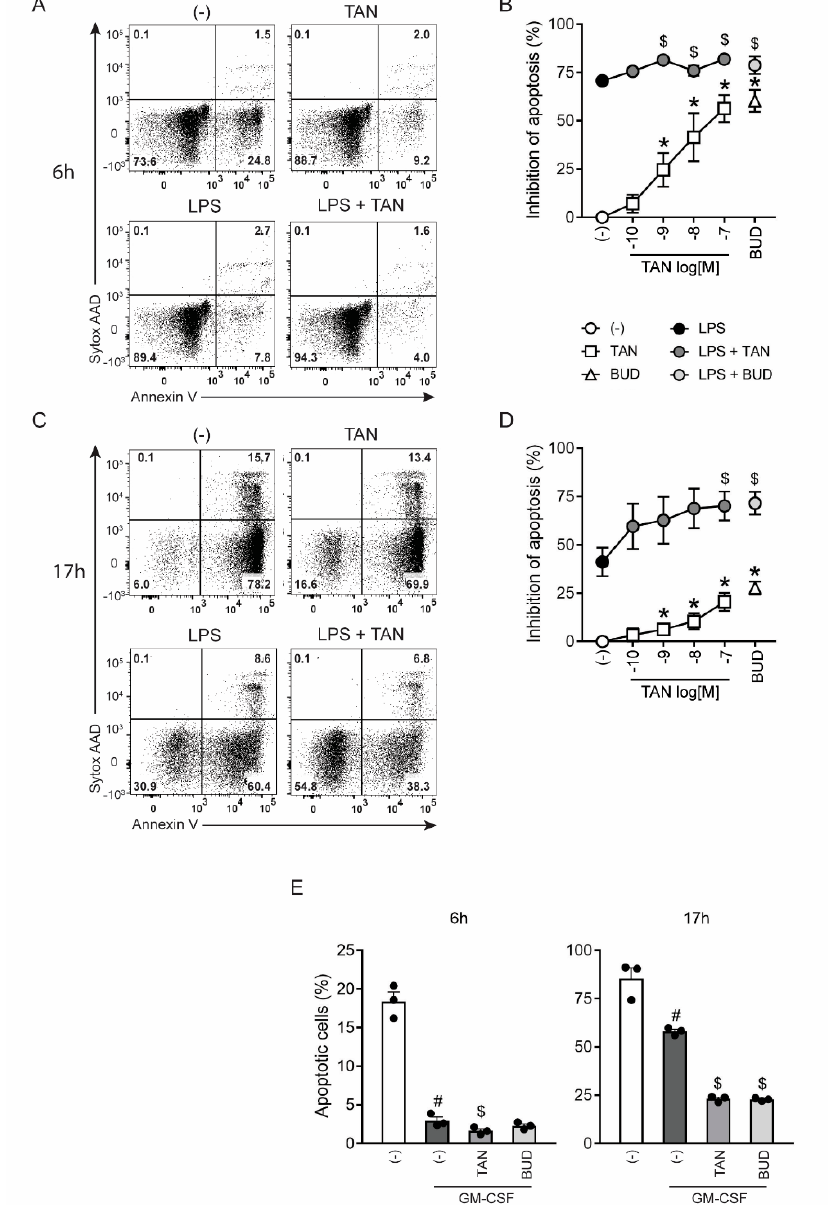
Figure 6. Tanimilast protects neutrophils from apoptosis. ( A – D ) Isolated neutrophils were exposed to the indicated concentrations of tanimilast and budesonide (10 − 7 M) in the absence or presence of LPS (500 ng/mL) ( A – D ). ( E ) Neutrophils were exposed to tanimilast or budesonide (both at 10 − 7 M) in the presence or absence of GM-CSF (20 ng/mL). Neutrophil apoptosis was assessed by cytofluorimetric analysis of Annexin V positivity in 7-AAD negative cells at 6 ( A , B , E left panel) and 17 h ( C , D , E right panel). ( A , C ) Dot plot from the analysis of one representative donor out of the four. ( B , D ) inhibition of apoptosis (%) by tanimilast (TAN) and budesonide (BUD), in unstimulated (open symbols) and LPS-stimulated neutrophils (closed symbols). Results are expressed as the mean ± SEM from the four independent donors. ( E ) Graphs depict the number of Annexin V positive in 7-AAD negative cells. Results are expressed as the mean ± SEM from three independent donors. Dots represent the result of individual donors ( n = 3). * p < 0.05% One-Sample t -test; # p < 0.05% Student’s t -test; $ p < 0.05% One-way ANOVA followed by post-hoc test. The effect of tanimilast on neutrophil apoptosis was also assessed after 17 h of cul- ture, when the percentage of apoptotic cells was 72.5 ± 1.71 in untreated samples and 50.2 ± 5.15 in the presence of the pro-survival factor LPS (Figure 6C left panels and not shown).